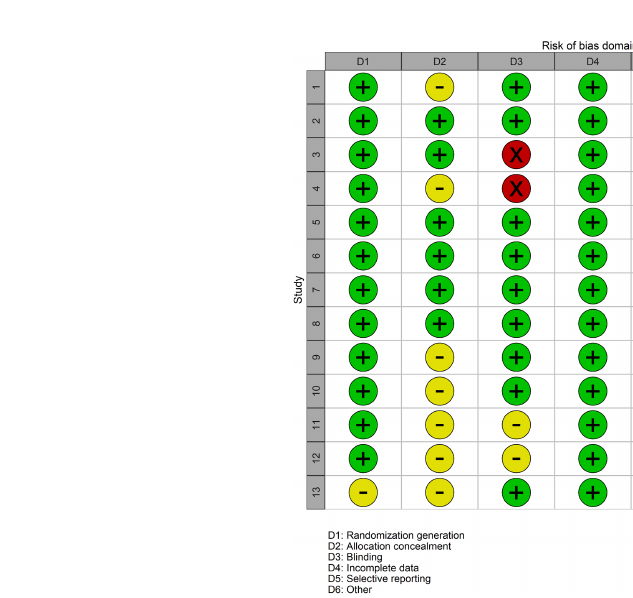
FIGURE 3 | Risk of bias diagram and summary evaluation of every risk of bias item for each involving experiment. Plus green circle, good; yellow circle, moderate; minus red circle,